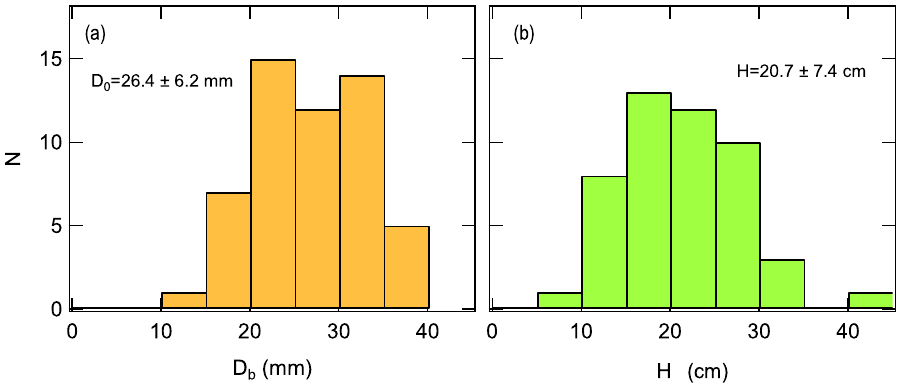
Fig 6. (a) Histogram of burrow diameters ( D b ) at the Tsu site. The maximum and minimum of tunnel diameter are 38 mm and 10 mm, respectively. (b) Histogram of the vertical depth ( H ) of burrows at the Tsu site. The maximum and minimum of depth values are 43 cm and 10 cm,